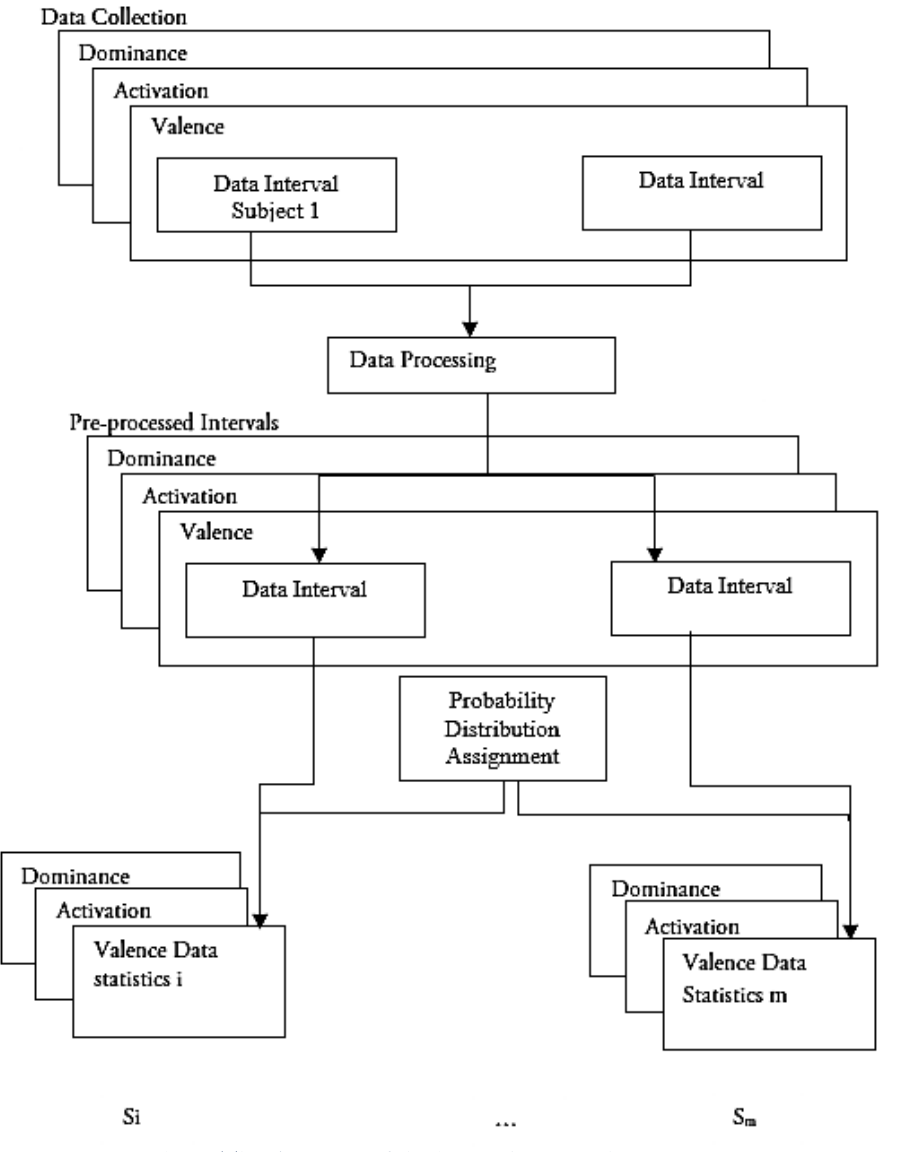
Fig. 2. The data part of the interval approach